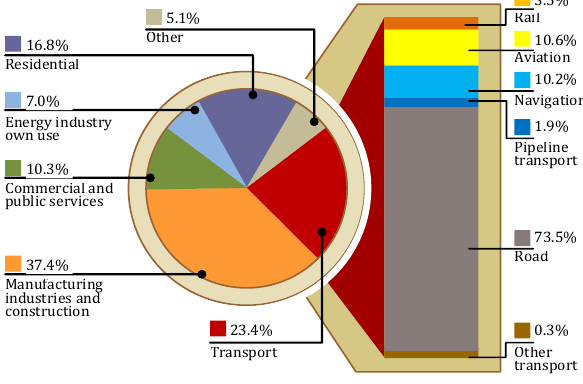
Fig. 1. Carbon dioxide emission as a result of fossil fuel combustion in various industry and transport sectors [24] The share of electrified railway lines increased by 163% in the span between 1975-2013 at the global level. China and Korea increased their share by 325% and 343% respec- tively between